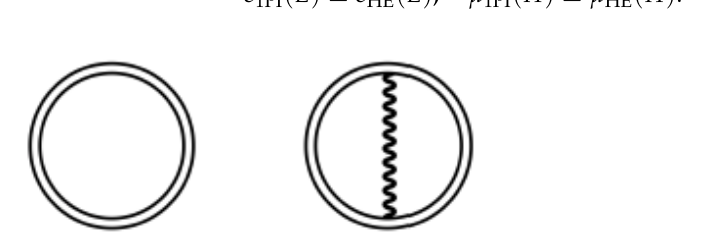
Figure 7. The 1PI effective action shown up to two-loops. Double solid line shows the electron Green function dressed by the background field. Wavy line shows photon Green